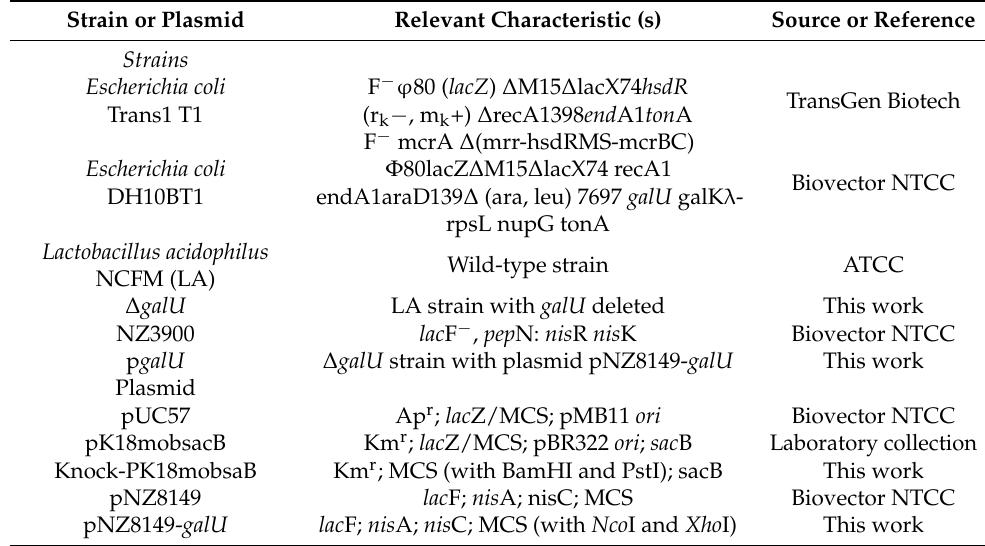
Table 1. The bacterial strains and plasmids used in this study. Strain or